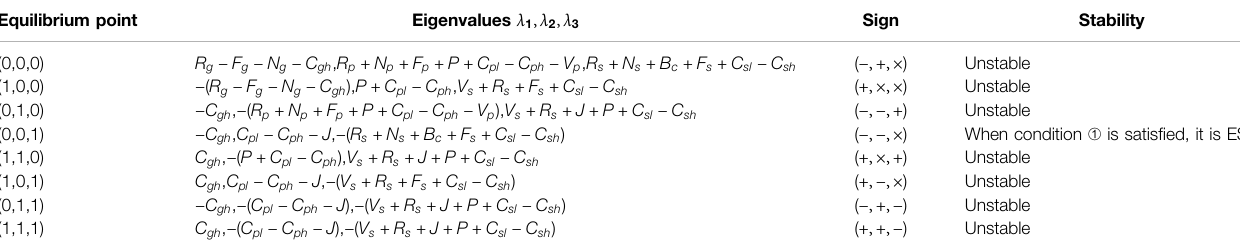
TABLE 3 | Stability analysis when consumer chooses complaint. Equilibrium point